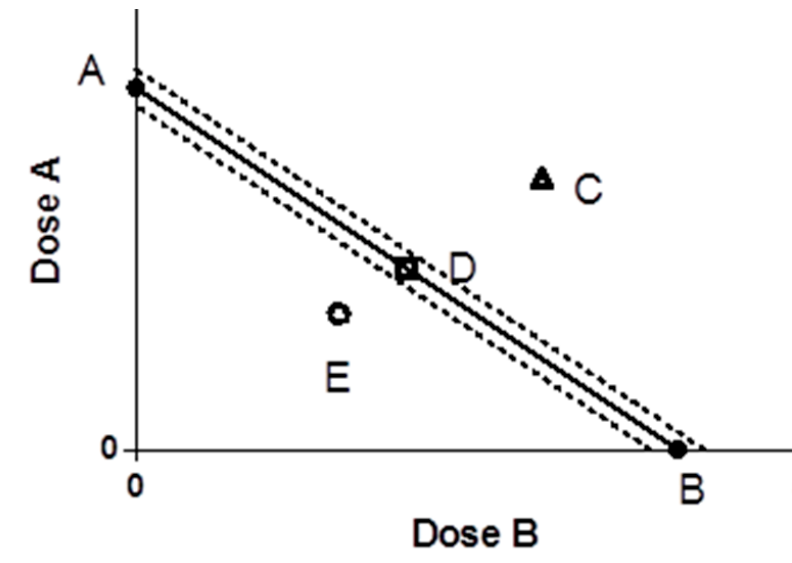
Figure 6. Isoradiation analysis of drugs A and B.